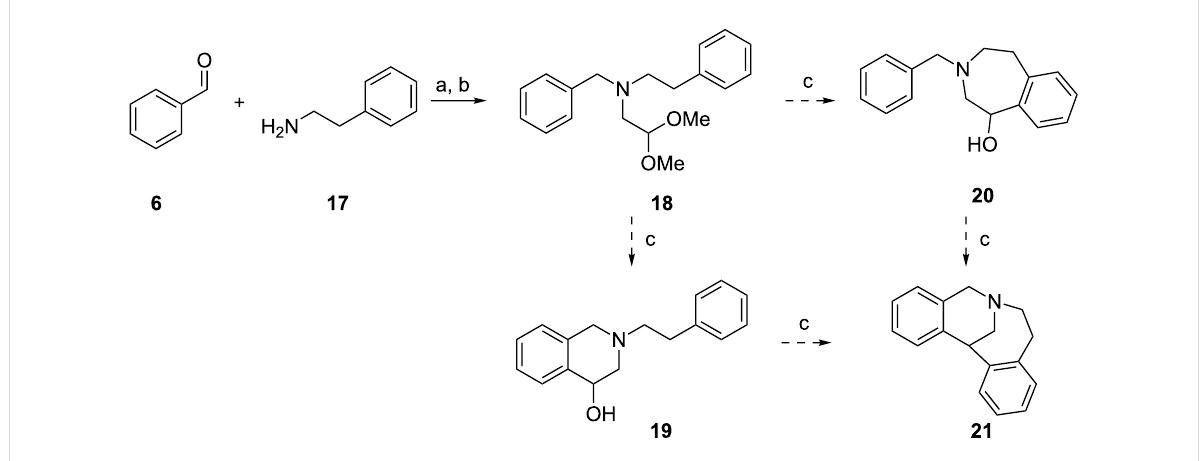
Scheme 7: Competition between 6- and 7-membered ring formation. Conditions: (a) NaBH(OAc) 3 , CHCl 3 , rt; (b) 2,2-dimethoxyacetaldehyde, NaBH(OAc) 3 , rt; (c) 70% HClO 4 , rt.